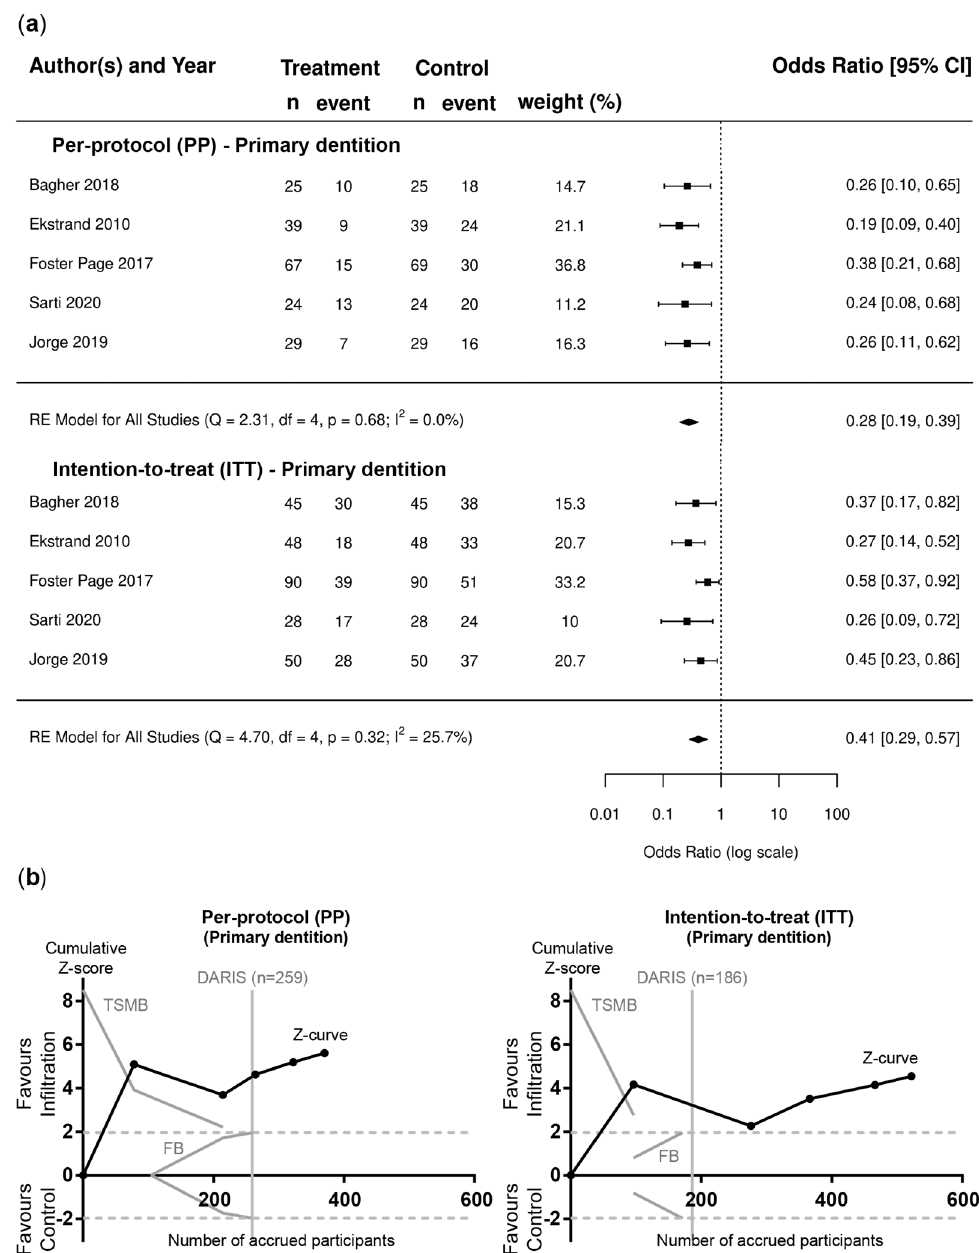
Figure 3. Primary dentition. ( a ) Forest plots of pairwise meta-analysis for PP and ITT scenarios. Risk of failure, i.e., lesion progression, is indicated for lesions in primary teeth treated with resin infiltration and non-invasive measures compared to non-invasive measures alone [63–67]. The odds ratio (OR) and 95% confidence intervals (CI) are shown. Heterogeneity is indicated by I 2 and Q statistics. Diamonds indicate pooled effect estimates. The number of lesions was adjusted using the design effect as described. ( b ) Trial sequential analysis (TSA) of trials evaluating lesions in primary teeth [63–67] for PP and ITT scenarios to assess the robustness of evidence. The cumulative Z-score (black curve), i.e., the accumulated level of significance, was plotted against the number of participants accrued so far, which was compared with the heterogeneity-adjusted required information size (DARIS), the conventional border (Z = 1.96), the trial sequential monitoring boundary (TSMB), and the futility border (FB) (grey oblique). For both scenarios, i.e., PP and ITT, the Z-curve crossed the conventional border and TSMB before reaching DARIS.